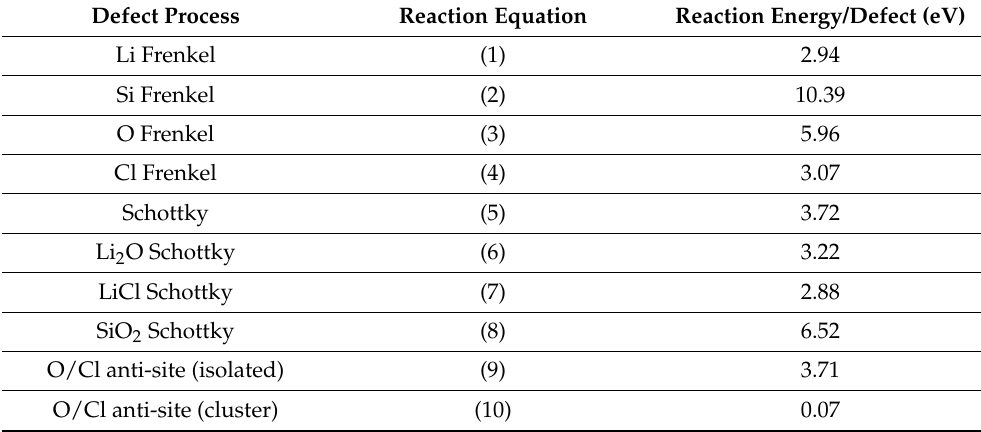
Table 3. Calculated intrinsic defect energies for different defect processes in Li 6 SiO 4 Cl 2